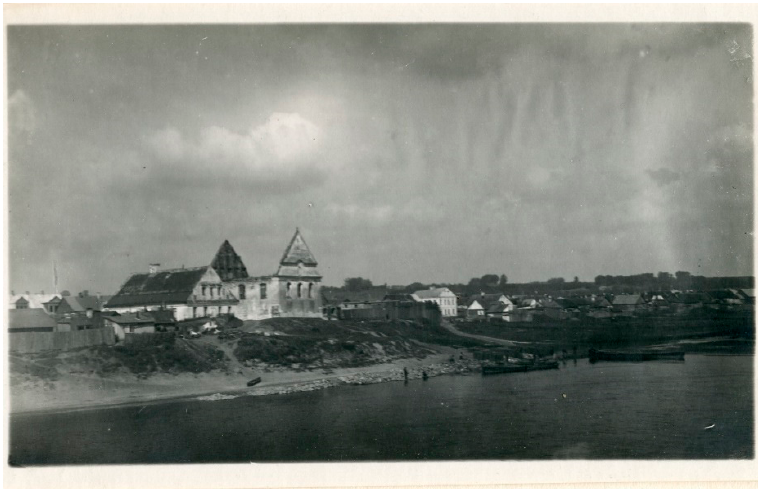
Figure 2. Ruins of Vilijampol˙e synagogue, 1920–1925. Cultural Heritage Centre, used with